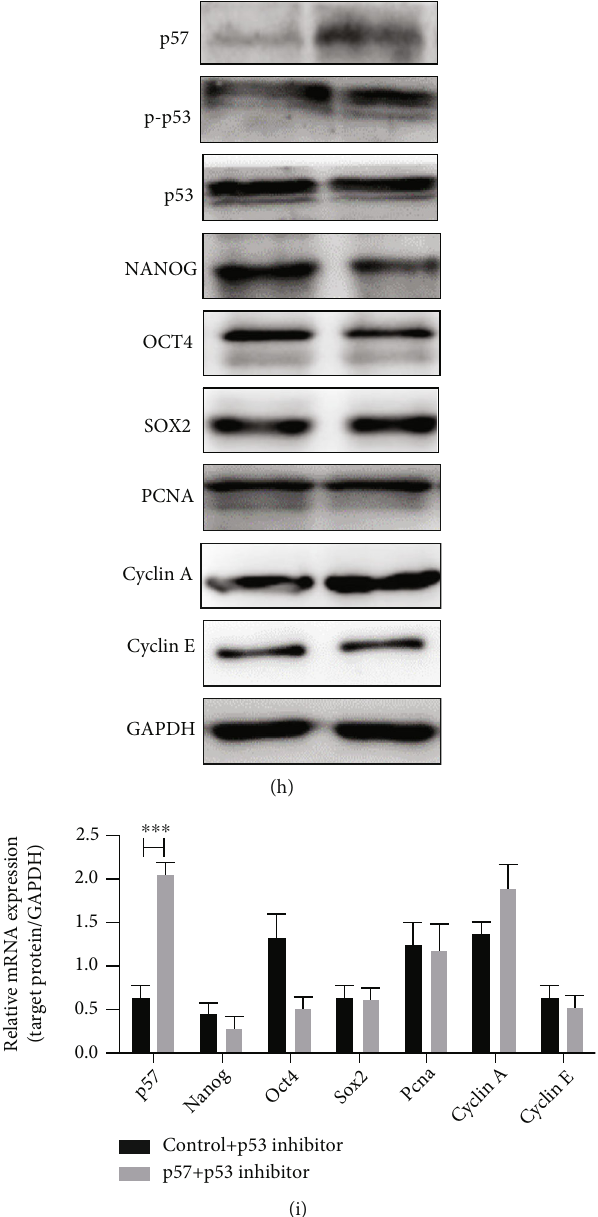
Figure 5: p57 interacted with and contributed to the activations of p53 in mESCs. (a) Visualization of p57-p53 interaction in vivo by BiFC assay ( n = 3 ). (b) Coimmunoprecipitation of p57 (Flag-p57) and p53. (c, d) Western blot and related densitometric analysis of p53 and its phosphorylation level at Ser 315 in control and p57 knockdown (shp57) mESCs. (e, f) Western blot and related densitometric analysis of p53 and its phosphorylation level at Ser 315 in control and p57-overexpressing (p57) mESCs. (g) Real-time PCR analyses of p57 , Nanog , Oct4 , Sox2 , Pcna , Cyclin A , and Cyclin E expression levels of control ( n = 3 ) and p57-overexpressing (p57, n = 3 ) mESCs treated with p53 inhibitor cultured for 48 h. (h, i) Western blot and related densitometric analysis of p57, p-p53, p53, NANOG, OCT4, SOX2, PCNA, Cyclin A, and Cyclin E expression levels of control and p57-overexpressing (p57) mESCs treated with p53 inhibitor cultured for 48h. Scale bar = 200 μ m. ∗ P < 0 : 05